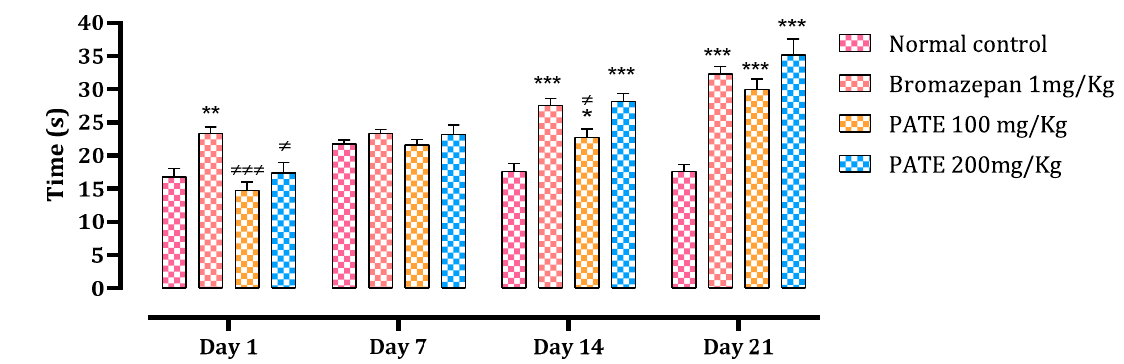
Figure 6. Effect of PATE on time spent variation at the center of the open field in mice. Data are represented as mean ± SEM. (* p ≤ 0.05, ** p ≤ 0.01, *** p ≤ 0.001 compared to the normal control. ≠ p ≤ 0.05, ≠≠≠ p ≤ 0.001) compared to the positive control.